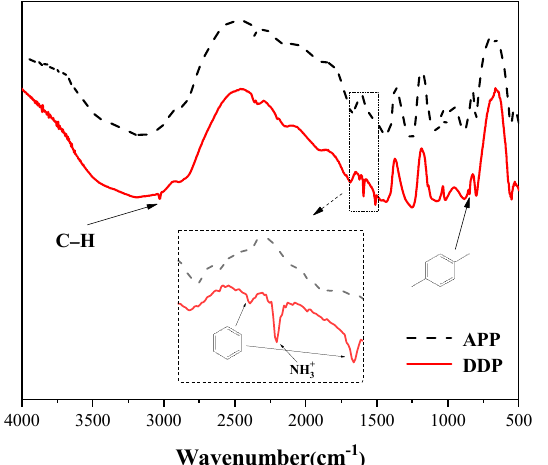
Figure 2. FTIR spectra of DDP and APP.